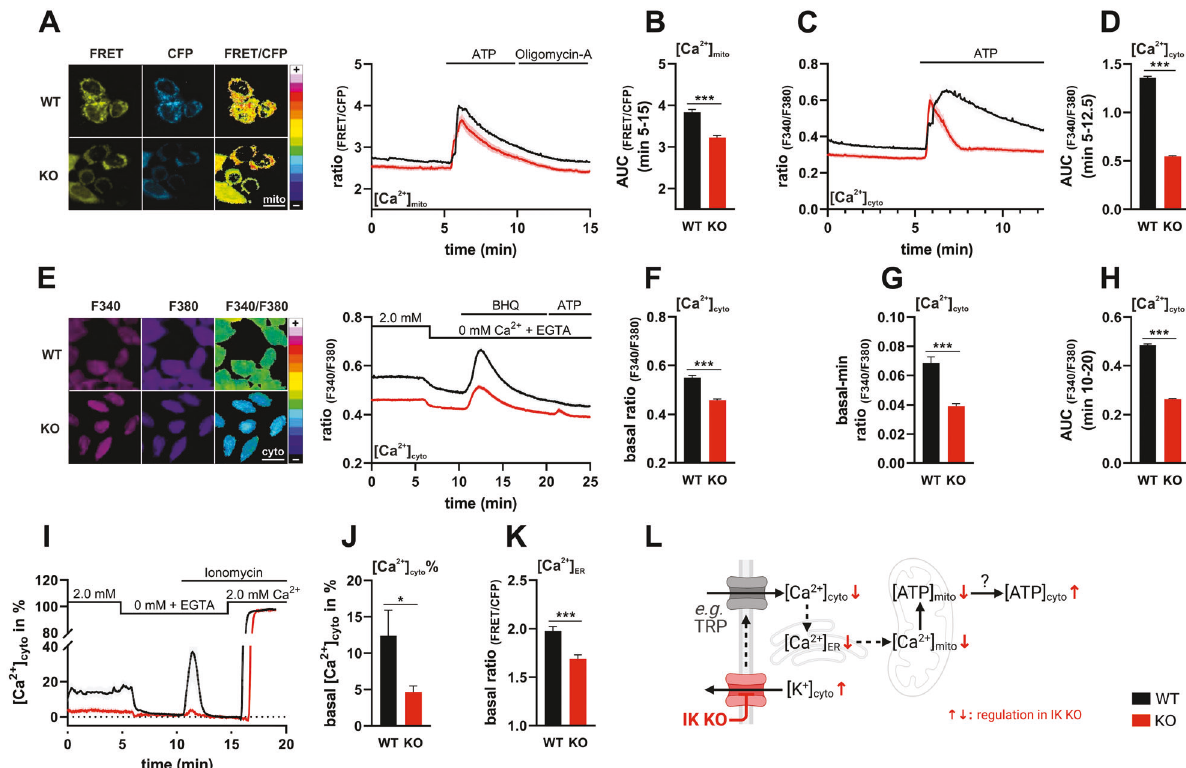
Fig. 3 Loss of IK impacts subcellular Ca 2 + homeostasis. A Representative FRET (left panel, yellow, left), CFP (left panel, cyan, middle), and pseudocoloured FRET-ratio images (left panel, 16-colors, right) and FRET-ratio signals over-time (right panel) of MMTV-PyMT WT (black) and MMTV-PyMT IK KO cells (red) expressing 4mtD3cpv , a FRET-based mitochondrial Ca 2 + indicator ([Ca 2 + ] mito ). At time point indicated in the panel, either extracellular ATP, to trigger release of Ca 2 + from intracellular stores via metabotropic receptors, or Oligomycin-A for inhibition of ATP synthase were administered. Scalebar = 20 µm. B Area under the curve (AUC) from timepoints 5 – 15 min of FRET-ratio signals as shown in A . Data represents average ±SEM, n = 6 with *** p ≤ 0.001, unpaired t -test with Welch ’ s correction for different varriances. C Fluorescence emission ratio signals of MMTV-PyMT WT (black line) and MMTV-PyMT IK KO cells (red line) loaded with FURA-2 over-time in response to administration of extracellular ATP at time point indicated in the panel. Data represents average ±SEM, n = 6 independent experiments per genotype. D Area under the curve (AUC) from timepoints 5 – 12.5 min of FRET-ratio signals as shown in C represent average ±SEM, n = 6 with *** p ≤ 0.001, unpaired t -test with Welch ’ s correction for different varriances. E Representative images of MMTV-PyMT WT (left panel, upper lane, and right panel, black curve) and MMTV-PyMT IK KO cells (left panel, lower lane, and right panel red curve) loaded with FURA-2, either at an excitation of 340 nm (left panel, pink, left) or 380 nm (left panel, violette, middle). Right images show pseudocoloured ratio image (left panel, 16-colors, right). FURA-2-ratio signals were recorded over-time (right panel) of MMTV-PyMT WT (black) and MMTV-PyMT IK KO cells (red) in response to extracellular removal of Ca 2 + (0 mM Ca 2 + + EGTA), administration of BHQ for SERCA inhibition, or cell stimulation with ATP at indicated timepoints. Data represents average ±SEM of n = 6 independent experiments per genotype. Scalebar = 20 µm. In F basal FURA-2 ratio signals (timepoints 0 – 5 in E ), G the difference of basal- to the minimal FURA-2 ratios of timepoints 5 – 10 min and H area under the curve (AUC) from timepoints 10 – 20 min of MMTV-PyMT WT (black bars) and MMTV-PyMT IK KO cells (red bars) are shown. Data represent means ± SEM of n = 6 with *** p ≤ 0.001, unpaired t -test with Welch ’ s correction for different varriances. I Normalized fl uorescence over time signals of MMTV-PyMT WT (black line) and MMTV-PyMT IK KO cells (red line) expressing Car-GECO1 , a single FP-based, red fl uorescent Ca 2 + sensor located in the cytosol ([Ca 2 + ] cyto ). At time points indicated in the panel, extracellular Ca 2 + was removed (0 mM Ca 2 + + EGTA), Ionomycin was added and extracellular Ca 2 + (2.0 mM) was re-added. Data represents average ±SEM of n = 5 independent experiments per genotype. J Basal Ca 2 + MMTV-PyMT WT (black bar) and MMTV-PyMT IK KO cells (red bar) expressing Car-GECO1 (timepoints 0 – 5 in I ). Bars represent average ±SEM, n = 5 with * p ≤ 0.05, unpaired t -test. K Basal FRET-ratio signals (timepoints 0 – 5) of MMTV-PyMT WT (black bar) and MMTV-PyMT IK KO cells (red bar) expressing D1ER ([Ca 2 + ] ER ), a FRET-based Ca 2 + indicator targeted to the endoplasmic reticulum (ER). Data represents average ±SEM of n = 3 with *** p ≤ 0.001, unpaired t -test. L Putative consequences of IK channel de fi ciency on Ca 2 + signaling pathways in MMTV-PyMT BC cells. Figure created using